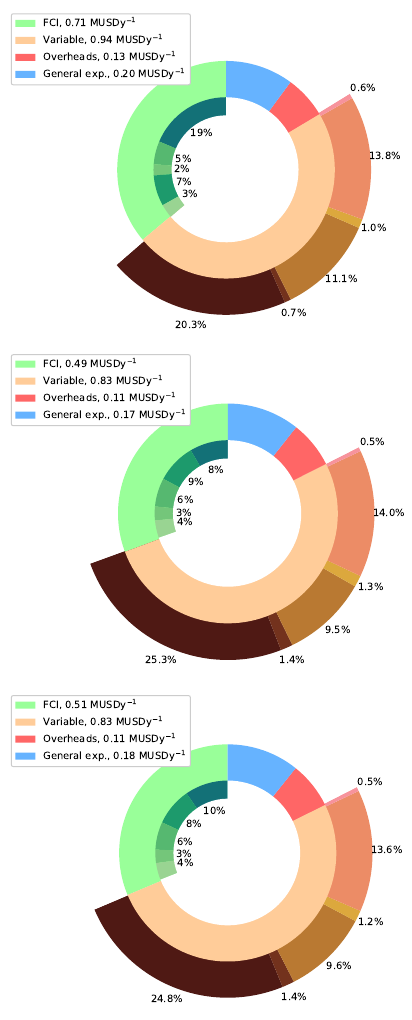
Figure 5. Depreciation of fixed capital investments (FCIs) per year (linear depreciation over 5y), Variable costs, plant overheads and general expenses (administration distribution, selling, and R&D) for the MRU in the base case scenario with the three feedstocks (price = 0USDy − 1 and FT fuel price = 0.3USDkg − 1 ). We outlined the contribution percentage of the main units to the FCIs (air compressor, natural gas compressor, water pump, CPOX reactor, FT reactor ) and to variable costs (labor, catalyst, maintenance, supervision, utilities, and supplies). Top: natural gas; middle: biogas; bottom: landfill